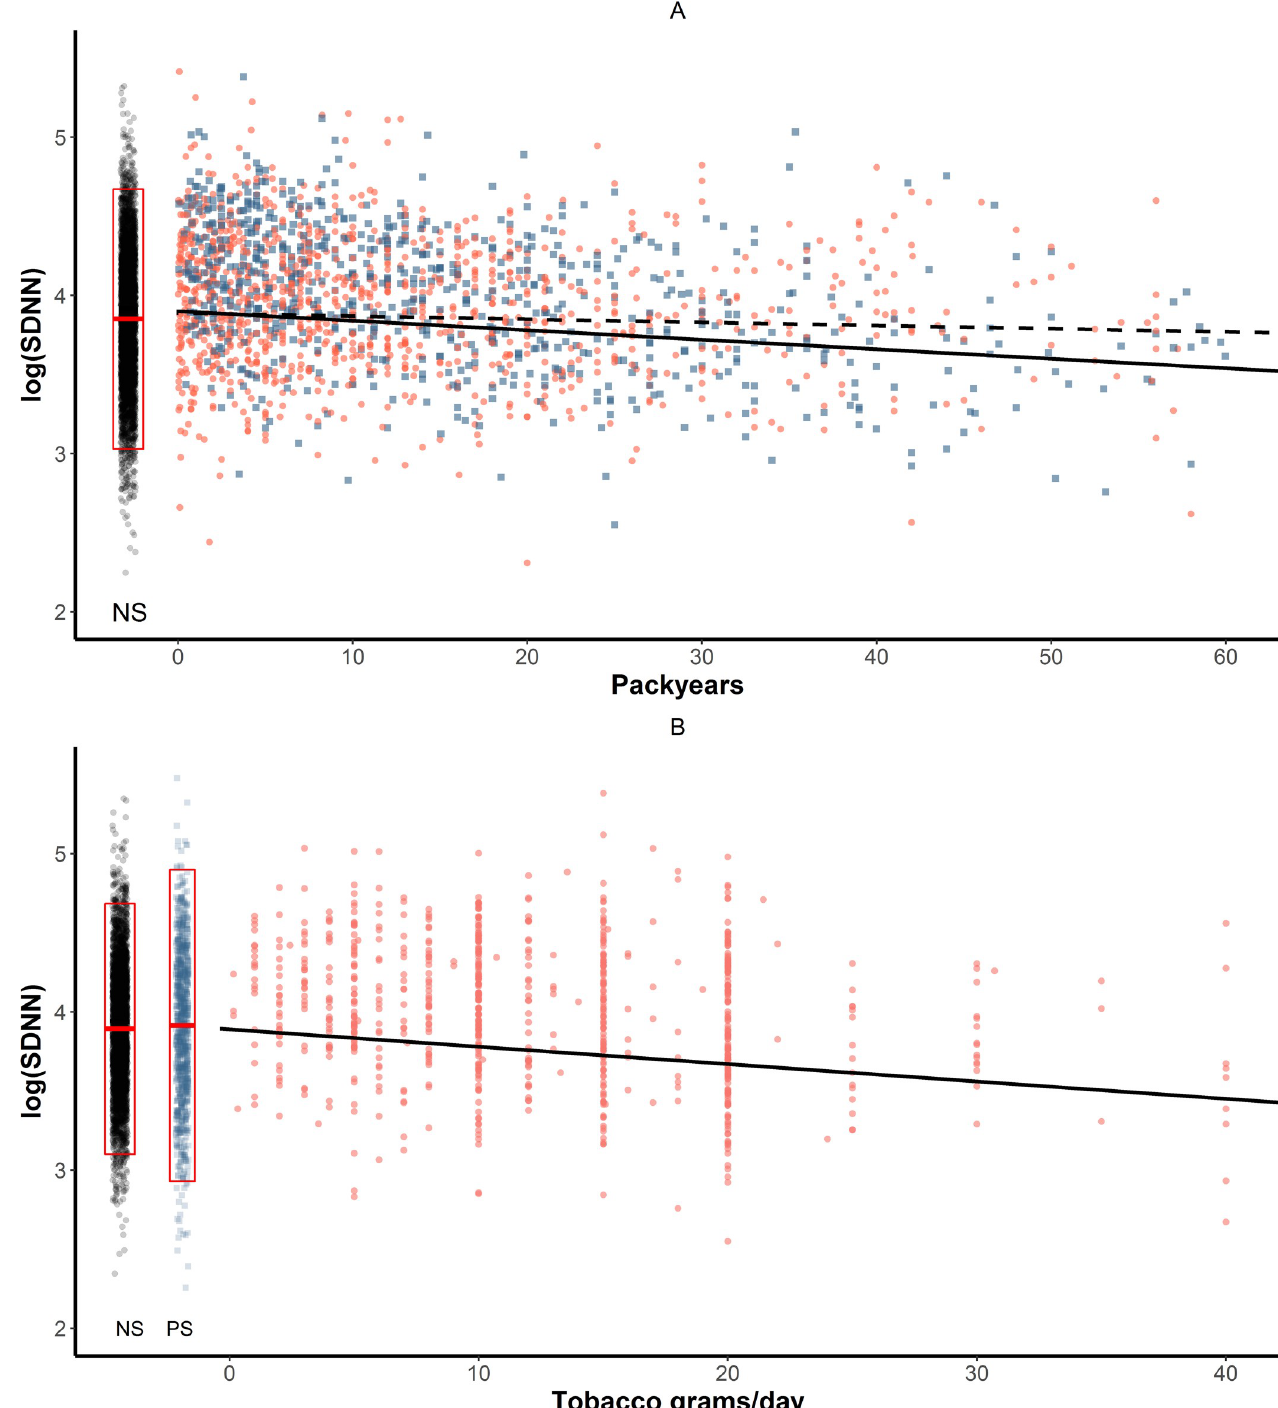
Fig 2. Effect of smoking status, history, and intensity on log(SDNN). ( A ) Never smokers (NS), indicated by black dots in the box-plot, are compared with ever smokers. The box represents the mean log(SDNN) ± 1 SD. Past and current smokers are identified by blue and red dots, respectively. Dashed and solid lines represent the fitted pack-years effect in past and current smokers, respectively, as obtained from Model C ; ( B ) Never smokers (NS, black dots) and past smokers (PS, blue squares) are compared with current smokers (red dots). Solid line represents the fitted effect of daily tobacco grams on log(SDNN) for current smokers. Measurement units: SDNN is expressed in